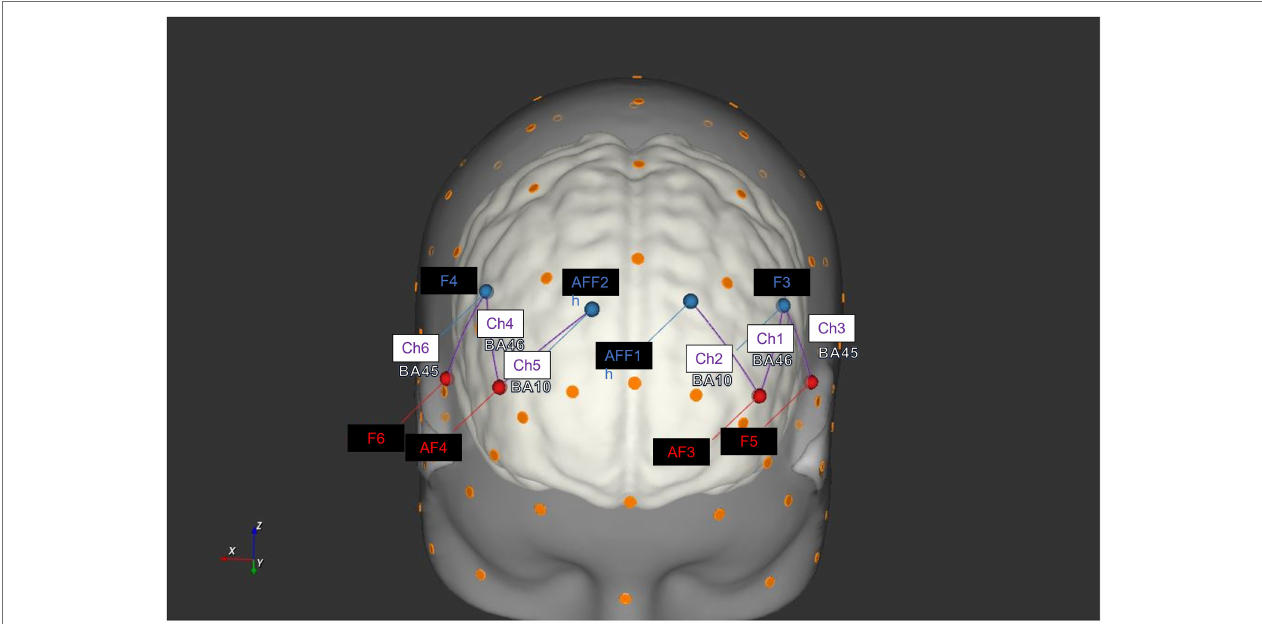
FIGURE 1 | Configuration of fNIRS probes. The head rendering displays the position of the fNIRS sources (red) and detectors (blue). It has been generated with software NIRSite (NIRx Medical Technologies LLC) and then adapted with the correspondence between the channels (violet) and Brodmann areas is indicated in the figure: Ch1 and Ch4 correspond to left and right DLPFC (BA 46); Ch2 and Ch5 cover the left and right frontopolar area (BA10), and a portion of left and right DLPFC (BA 46); and Ch3 and Ch6 are consistent with the left and right pars triangularis Broca’s area